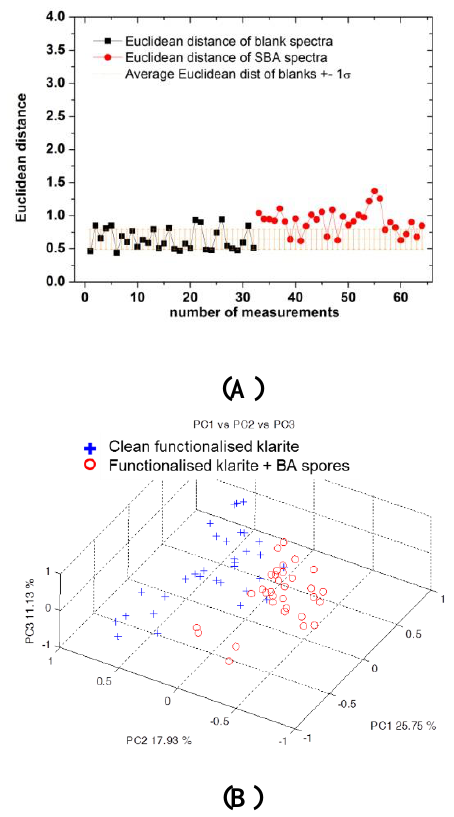
Figure 6. ( A ) Euclidean distance for the blank spectra (black dots) and Bacillus atrophaeus (SBA) spectra (red dots) compared to the average value of the Euclidian distance obtained for the blank spectra (the brown line shows the range individuated by mean value ± 1 s B ). ( B ) First three principal component (PC) score plots of the SERS spectra acquired on the clean cartridge (blue crosses) and inoculated with SBT (red dots).